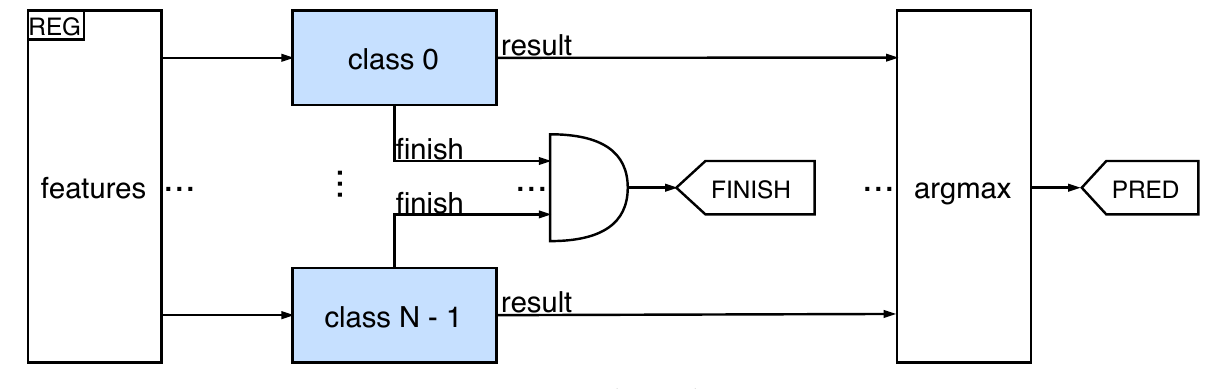
Figure 6. Accelerator design.